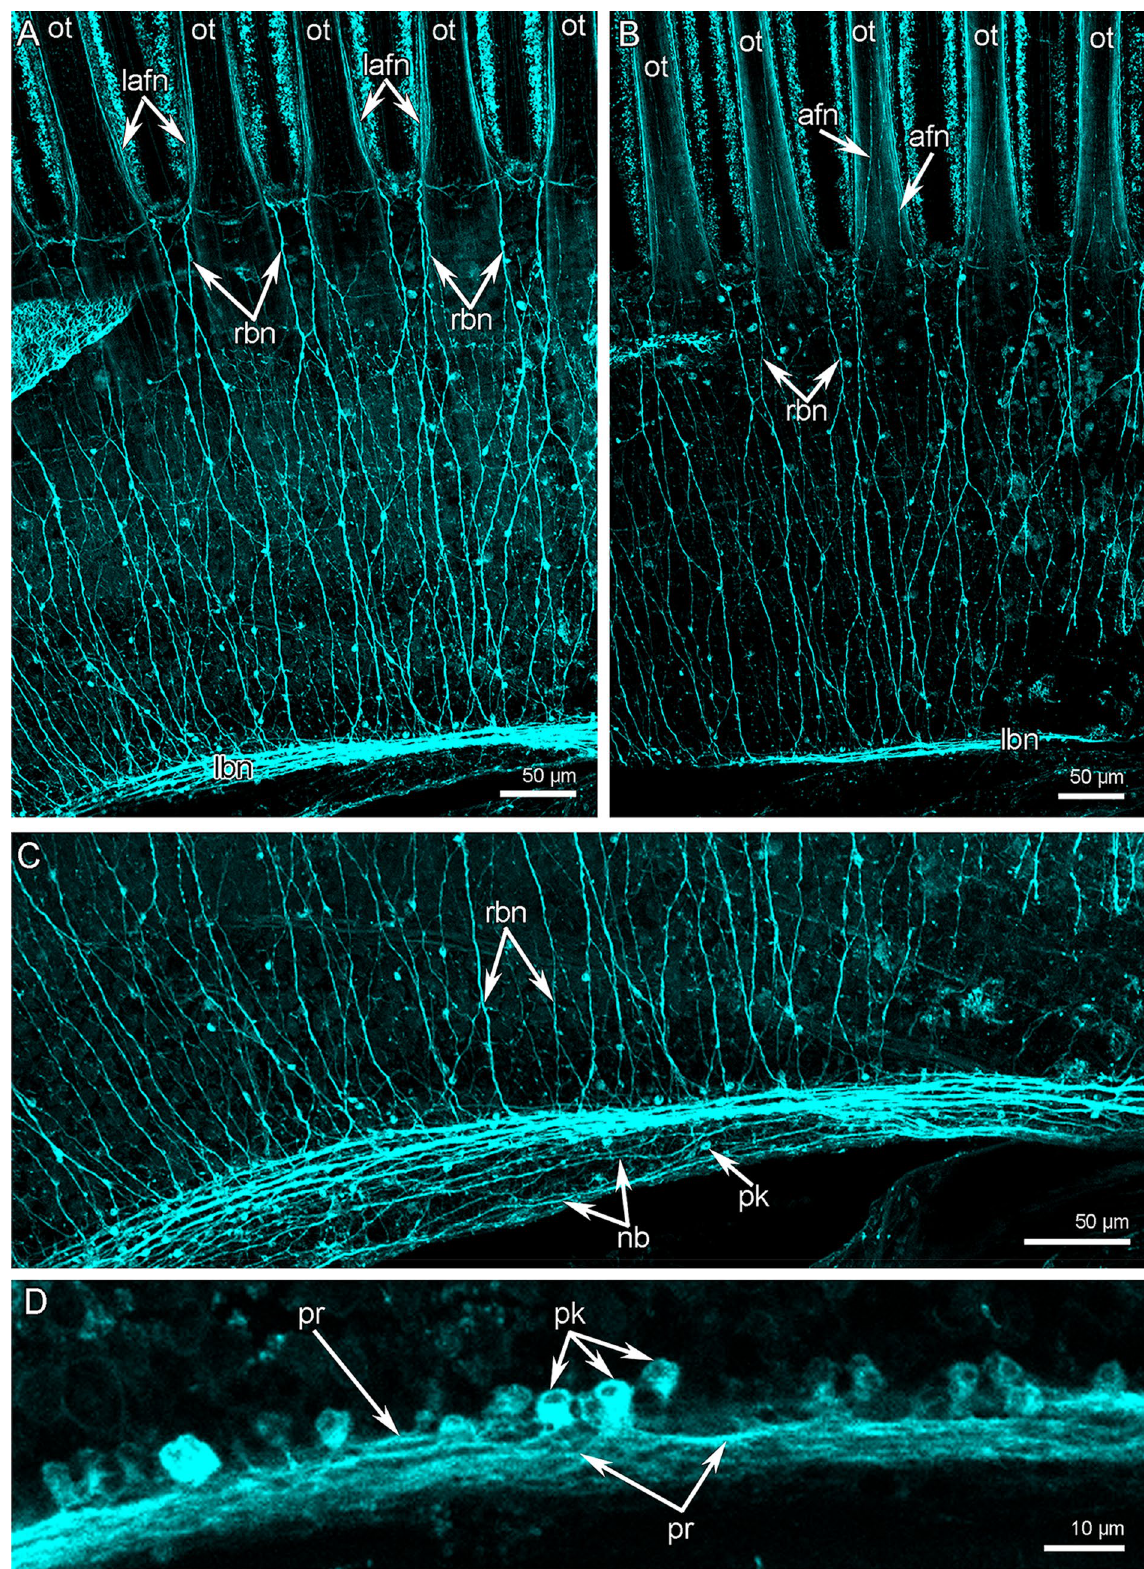
Figure 11. Organization of lower brachial nerve of Coptothyris grayi. Z-projections after immunostaining against acetylated alpha-tubulin (cyan). ( A ) A portion of the lateral arm viewed from the outer tentacles. ( B ) The most abfrontal side of outer tentacles. ( C ) A portion of the lower brachial nerve, which gives rise to the radial brachial nerves. ( D ) Magnified portion of the lower brachial nerve: perikarya and their projections are visible. Abbreviations: afn—abfrontal tentacle nerve; lafn—lateroabfrontal tentacle nerve; lbn—lower brachial nerve; nb—neurite bundle; ot—outer tentacle; pk—perikarya; pr—projection; rbn—radial brachial